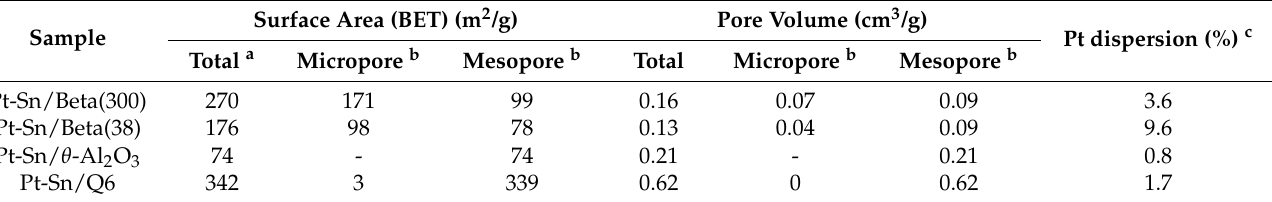
Pt dispersion (%) c